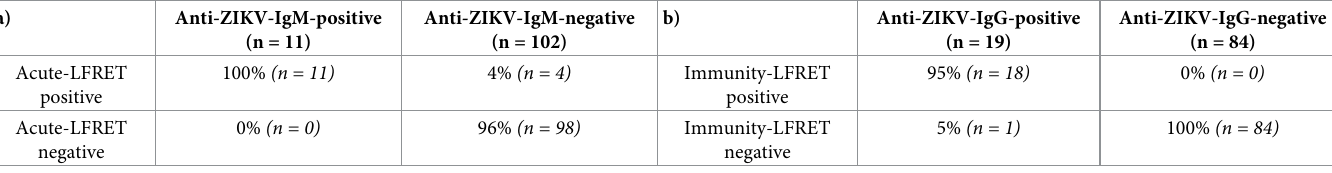
Table 3. Test outcomes in class-specific LFRET tests compared with the reference